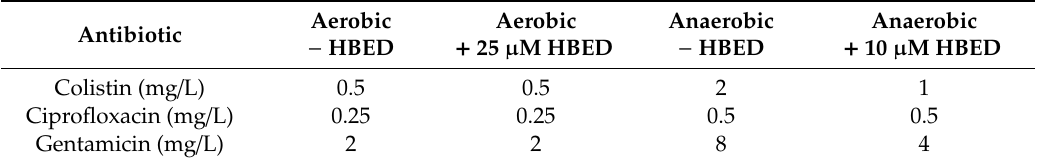
Table 1. Minimal inhibitory concentrations of antibiotics in the presence of N,N’-bis (2-hydroxybenzyl) ethylenediamine-N,N’-diacetic acid